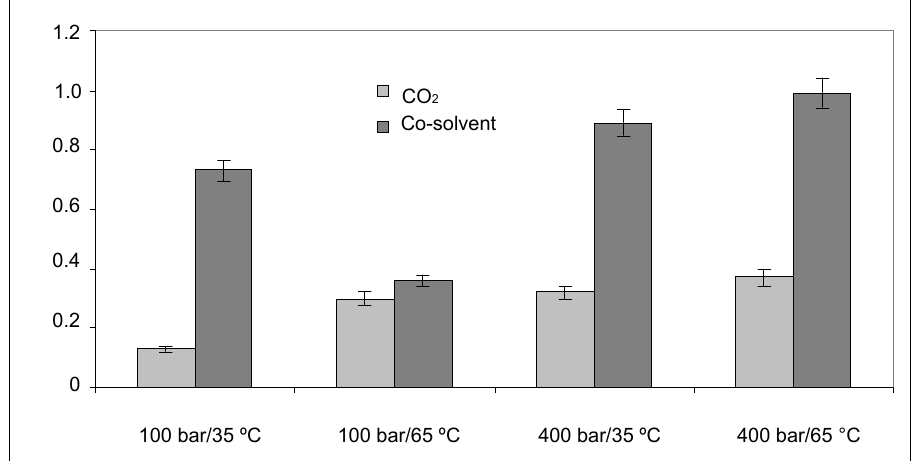
Figure 1. Extraction yield (%) of extracts obtained by SFE at different pressures and